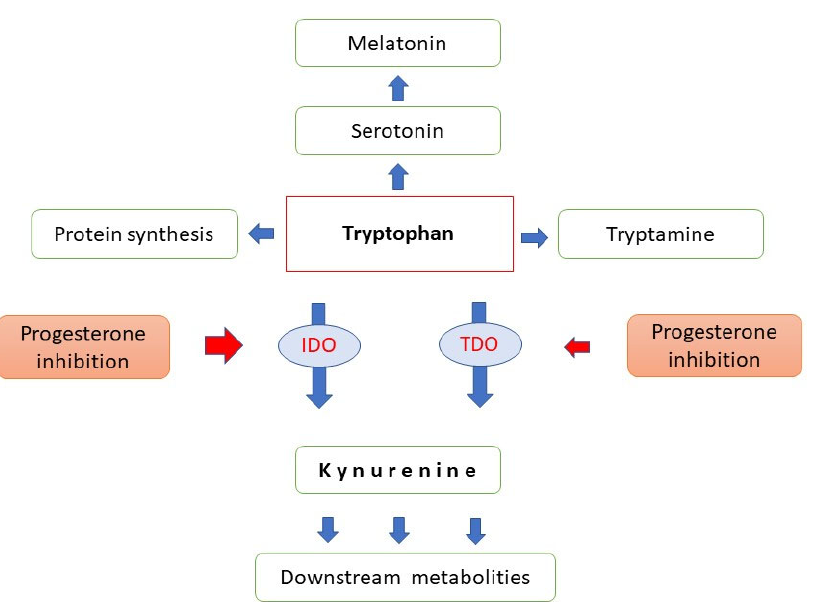
Figure 2. Major pathways of tryptophan metabolism. IDO: indoleamine-2,-3- dioxygenase, TDO: Figure 2. Major tryptophan-2,-3-dioxygenase, red arrows indicate progesterone